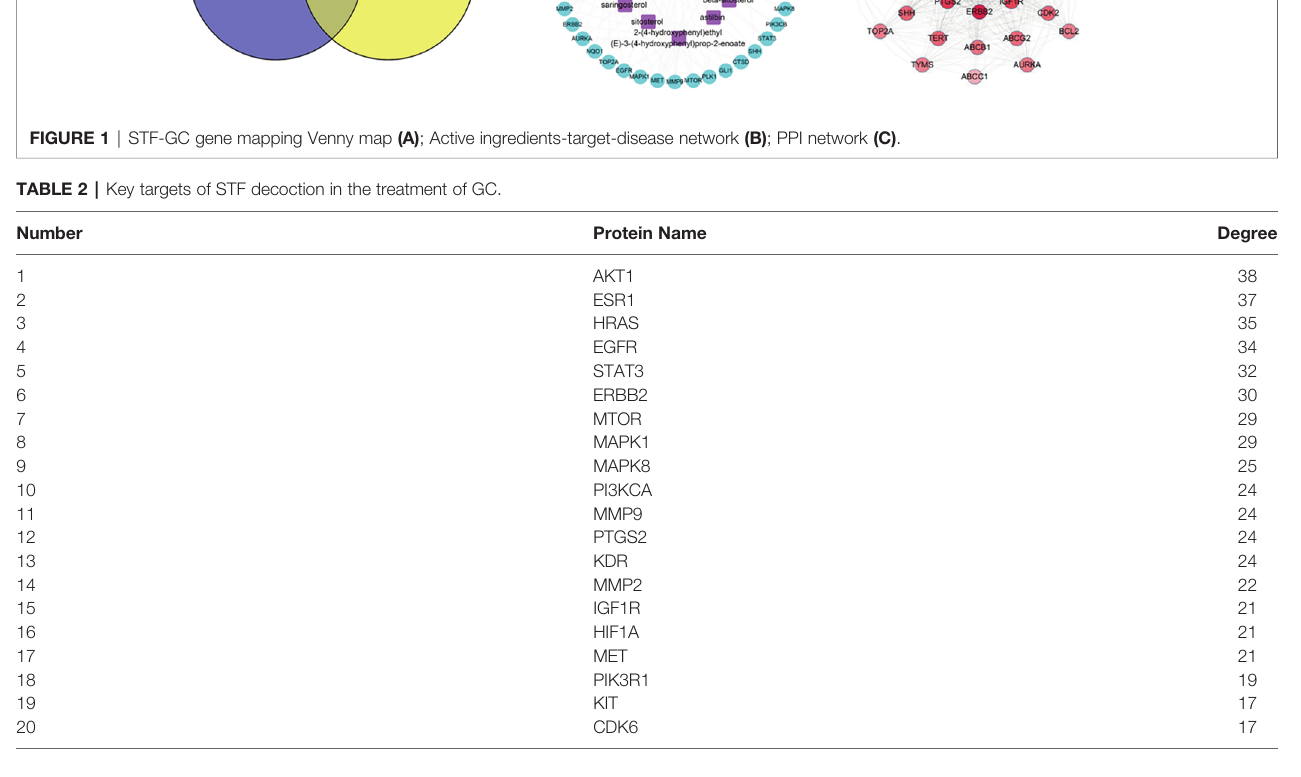
TABLE 3 | Core components of STF in the treatment of